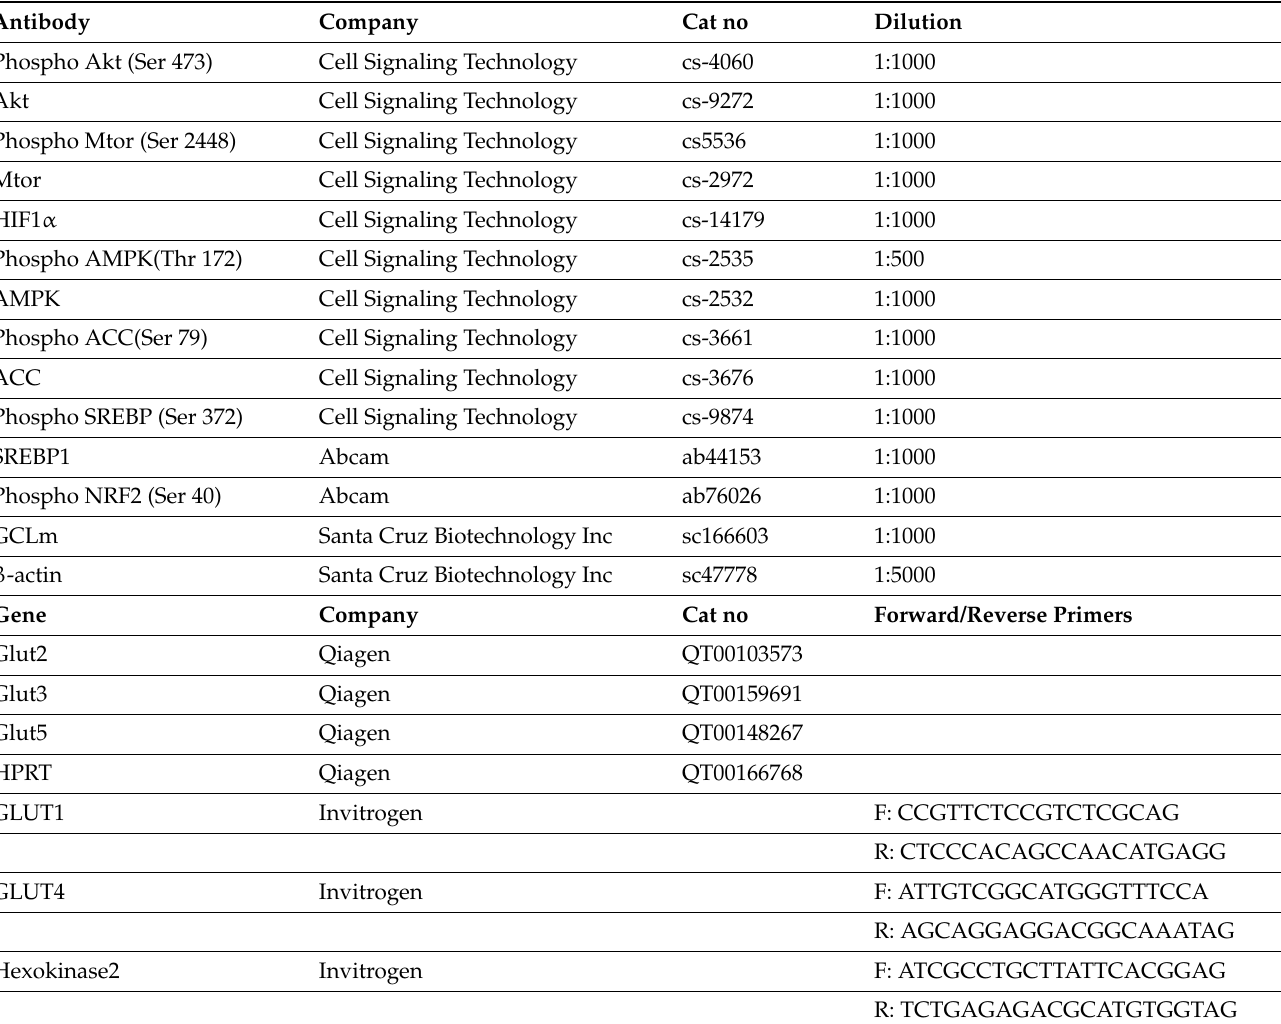
Table 1. Antibodies and